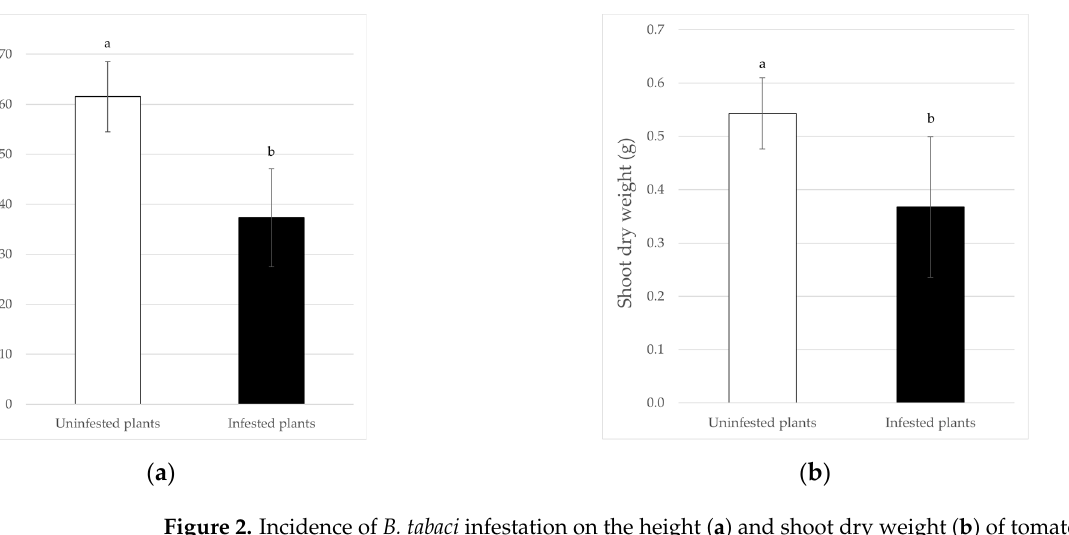
Figure 1. Mean number of eggs laid on the lower surface of each of the three selected leaves per plant.